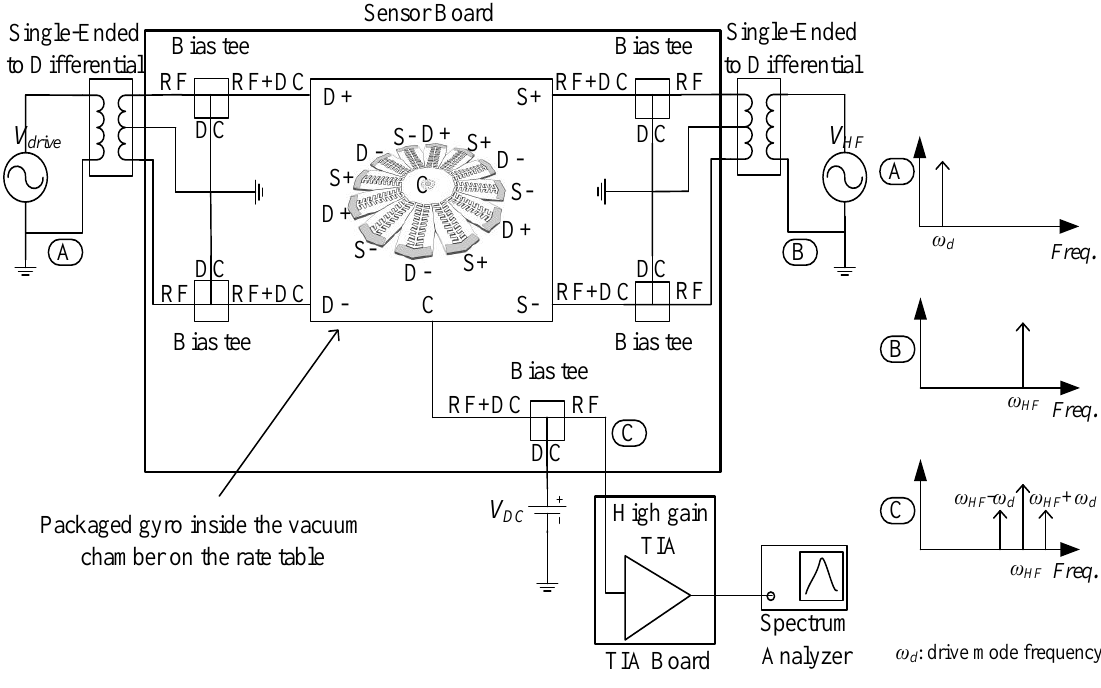
Figure 14. ( a ) Photograph of the test setup, ( b ) circuits and connections from inside the vacuum chamber, and ( c ) vacuum sealed electrical